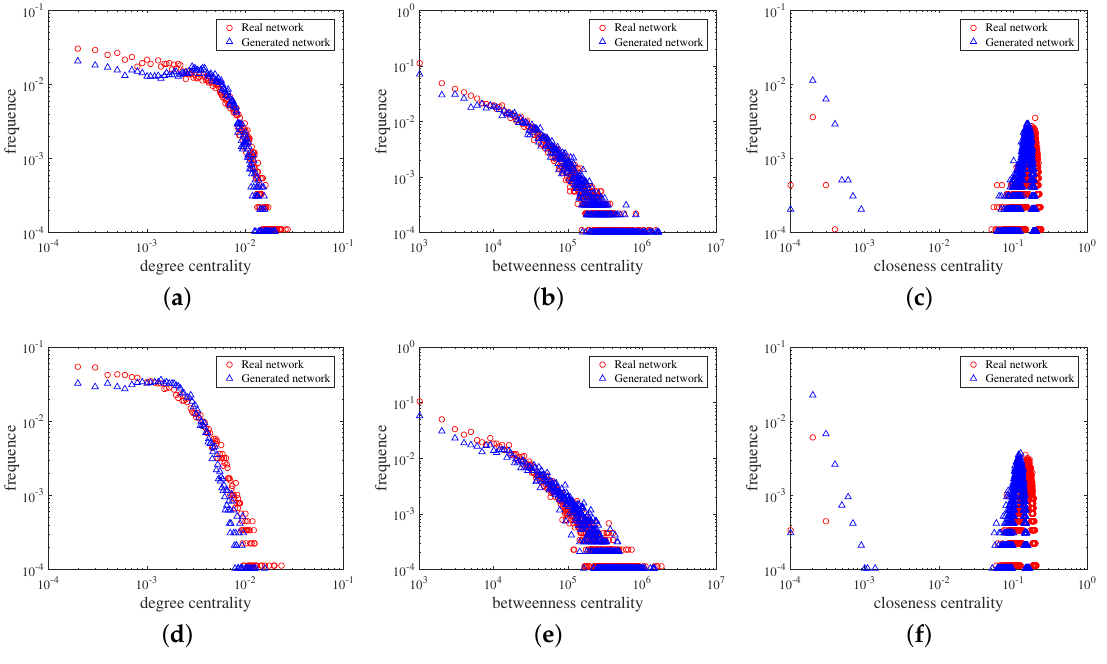
Figure 7. The comparison of the centrality distributions between the real network and the generated network. ( a ) Degree centrality distribution on weekdays. ( b ) Betweenness centrality distribution on weekdays. ( c ) Closeness centrality distribution on weekdays. ( d ) Degree centrality distribution on weekends. ( e ) Betweenness centrality distribution on weekends. ( f ) Closeness centrality distribution on weekends. The red circle represents the real network, and the blue triangle represents the generated network.